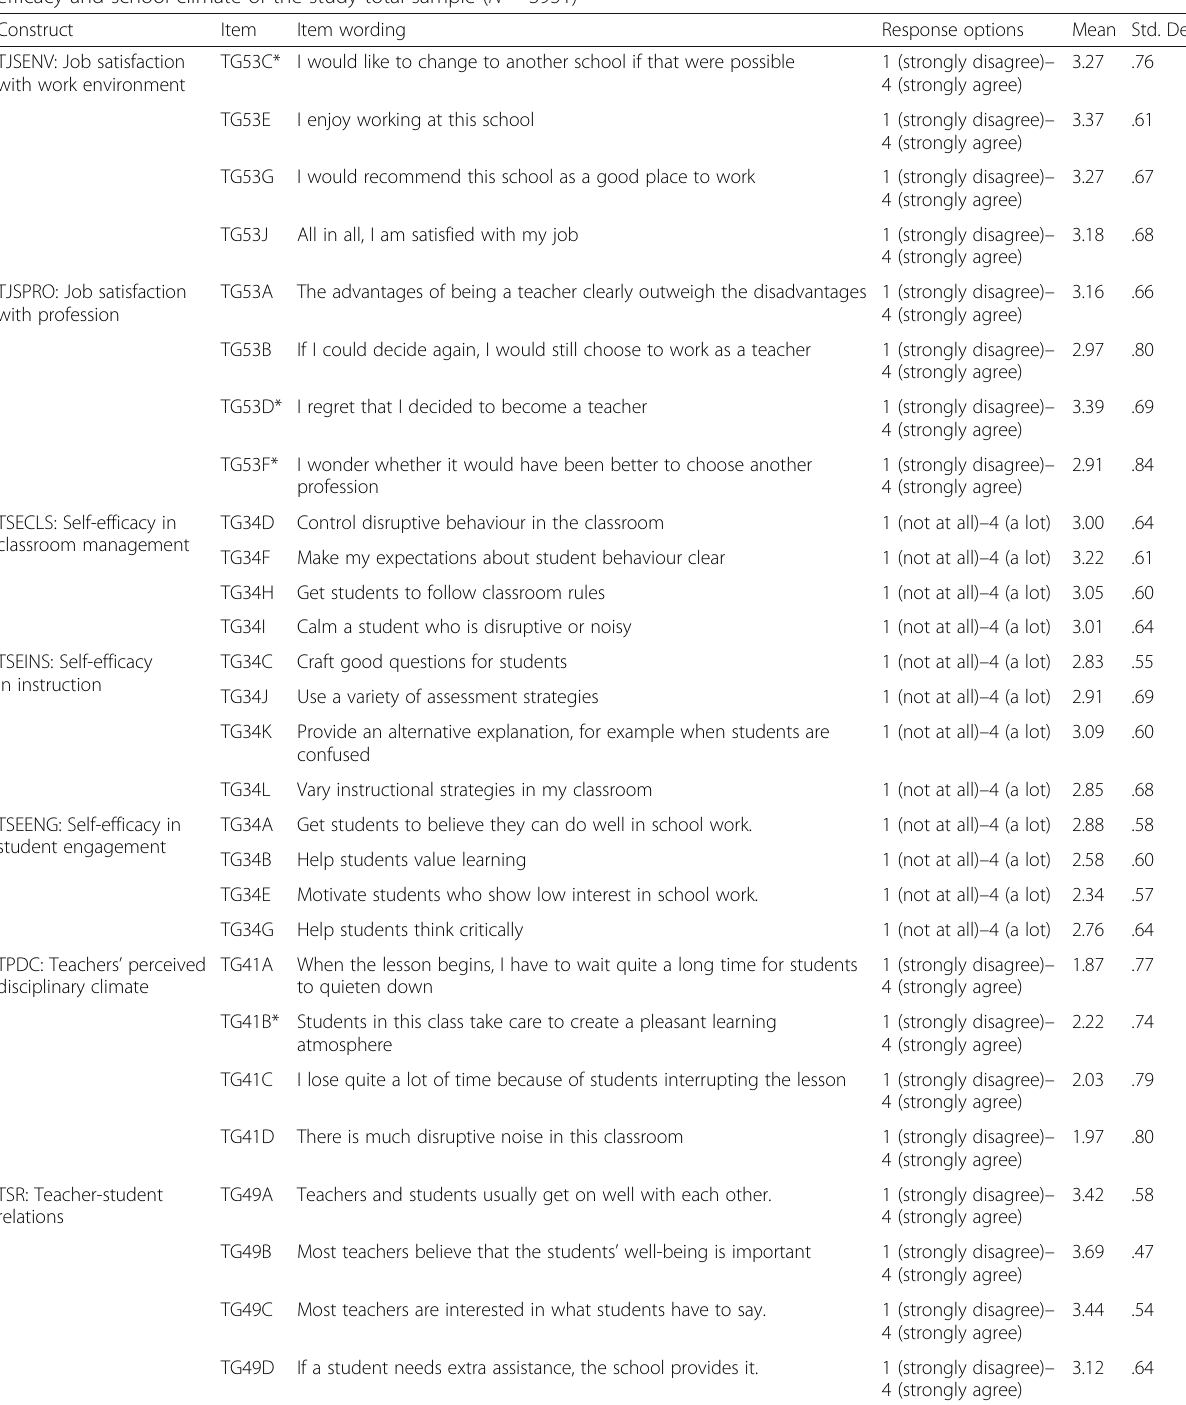
Table 1 Item wordings, response options, means and standard deviations of each construct measuring teacher job satisfaction, self- efficacy and school climate of the study total sample ( N = 3951) Construct Response options Mean Std.